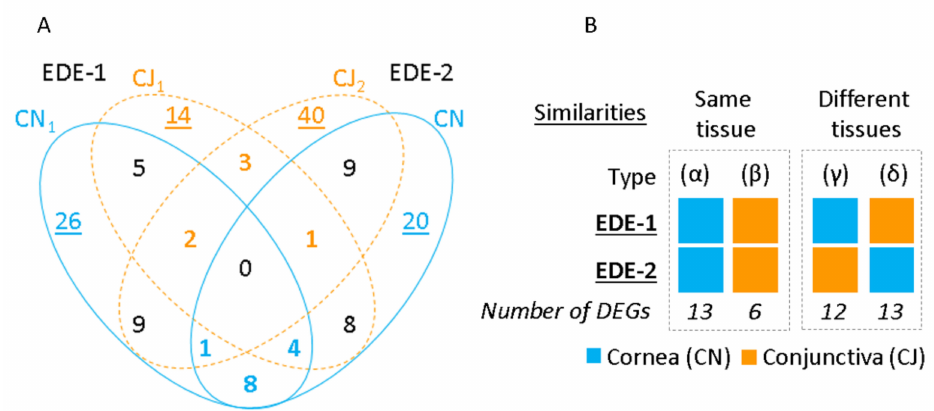
Figure 3. Tissue similarities and specificities between both EDE mouse models: ( A ) Venn diagram showing the overlap of DEGs between cornea and conjunctiva in each model. The colored and bold numbers highlight similarities within the same tissue, whereas underlined numbers indicate tissue specificity in both mouse models. ( B ) Four types of similarities between models according to tissue distribution are represented: within the same tissue as type ( α ) for cornea and type ( β ) for conjunctiva, and in different tissues as type ( γ ) and ( δ ) for cornea and conjunctiva of EDE-1 and EDE-2 respectively. Each EDE tissue is depicted as colored squares. The number of DEGs is represented for each type of group of